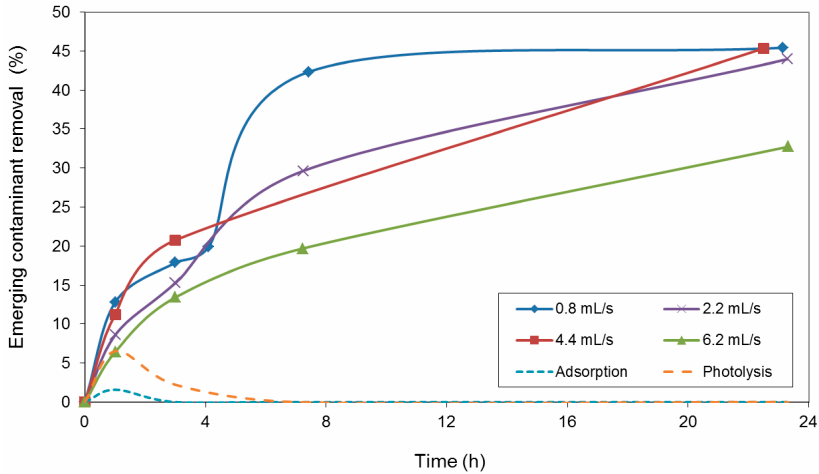
Figure 4. Emerging paracetamol removal in the fixed-bed photoreactor